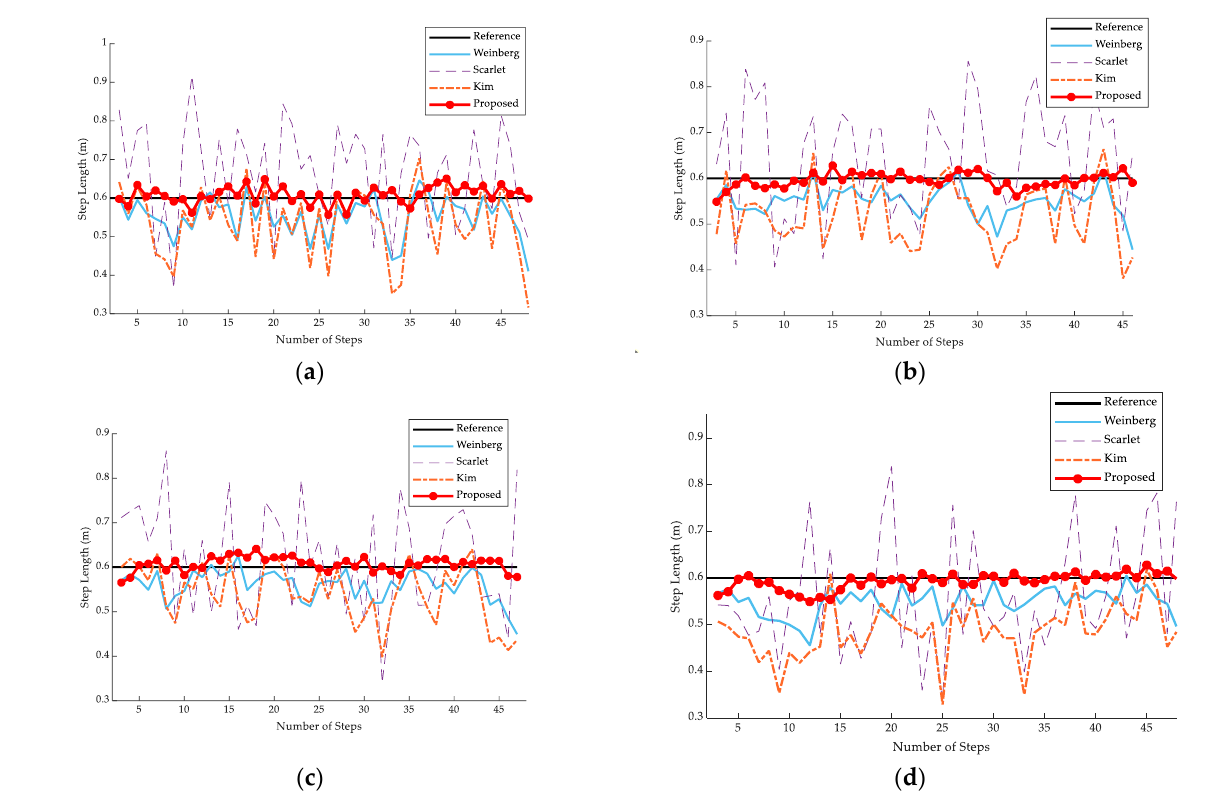
Figure 9. Step length estimation results with Honor60, VivoY85a, and two different height pedestrians in the first scene. ( a ) Volunteer #1 with a VivoY85a cell phone. ( b ) Volunteer #2 with a VivoY85a cell phone. ( c ) Volunteer #1 with an Honor60 cell phone. ( d ) Volunteer #2 with an Honor60 cell phone.